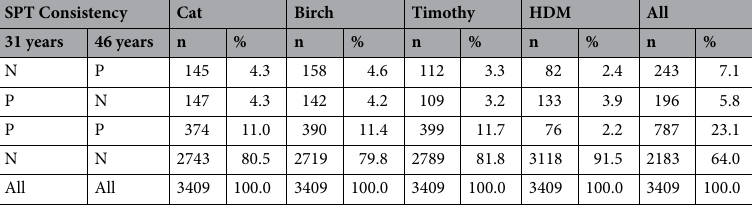
Table 2. Consistency of sensitization between ages 31 and 46 by allergen. SPT skin prick test, HDM house dust mite, N negative, P positive.